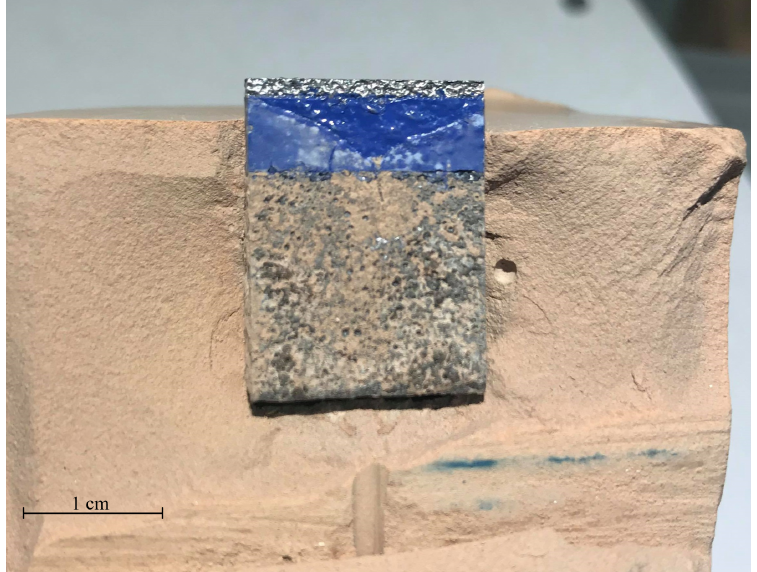
Figure 4. The aluminum cement interface after the aluminum sample has been in the cement paste for 28 days. There is no visual white corrosion product at the interface, indicating that the aluminum sample is compatible with the cement